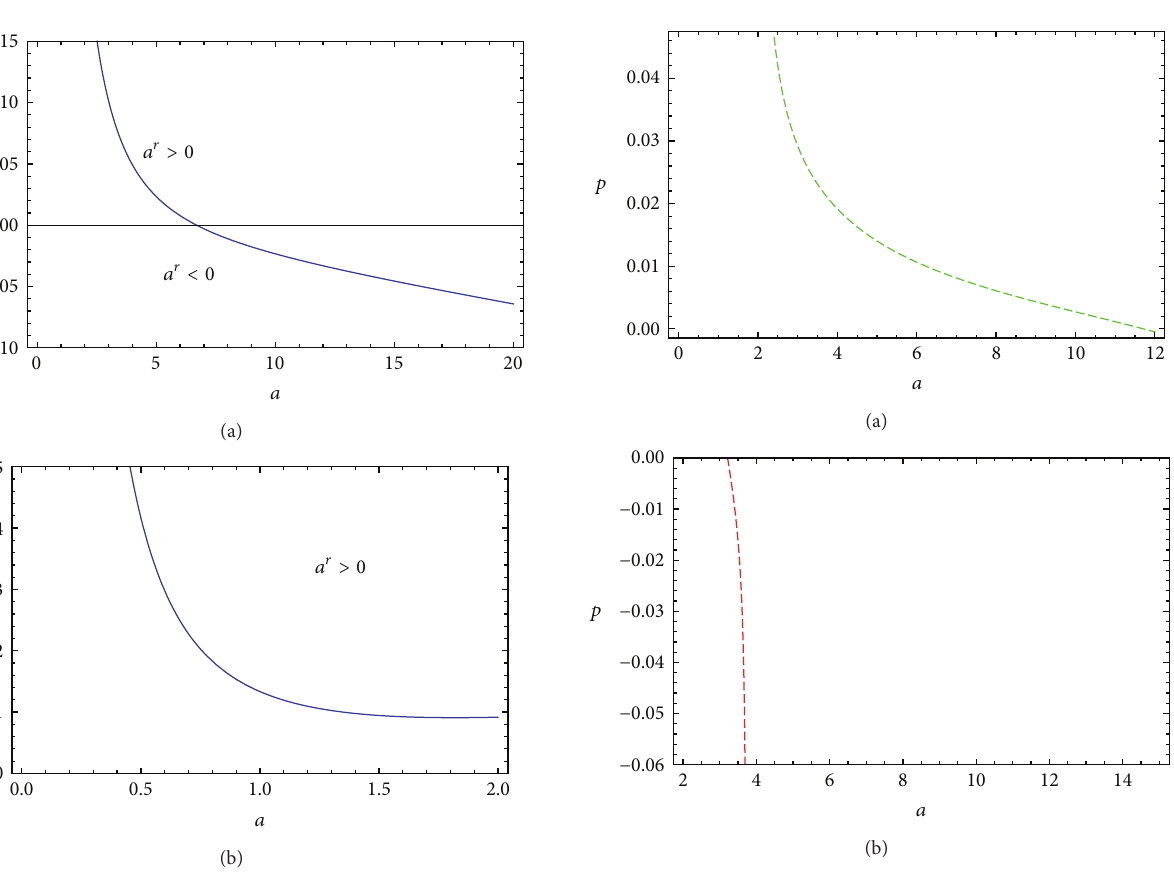
Figure 3: Plots of surface pressure for TSWs corresponding to 𝑀 = 0.2 , Λ = −0.1 (a) and surface tension for 𝑀 = 1 , Λ = 0.1